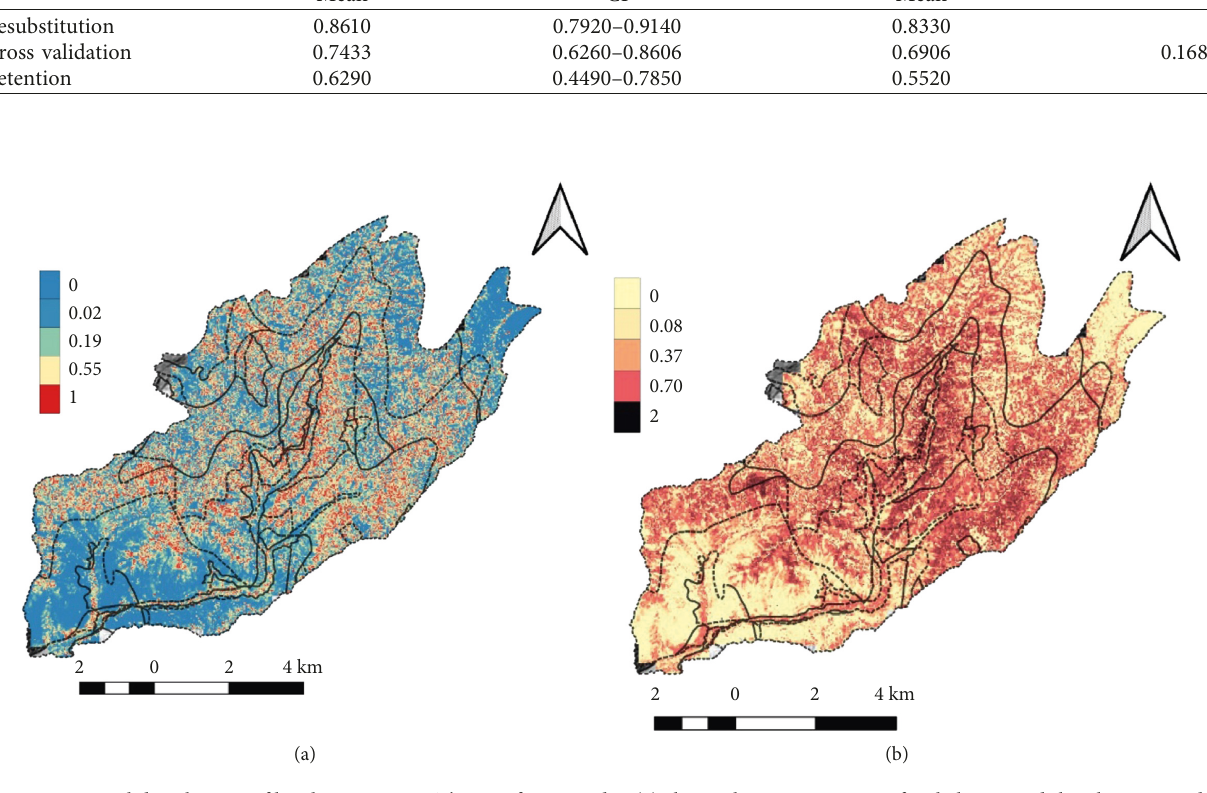
Figure 3: Spatial distribution of local uncertainty. The Confusion Index (a) shows the cooccurrence of soil classes and the Shannon Index (b) is an indicator of the presence of more than two soil